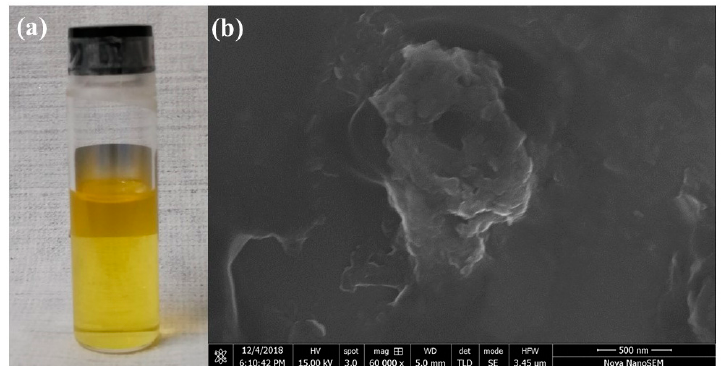
Figure 1. ( a ) Photograph ZrS 2 dispersion; ( b ) SEM image of ZrS 2 dispersion.